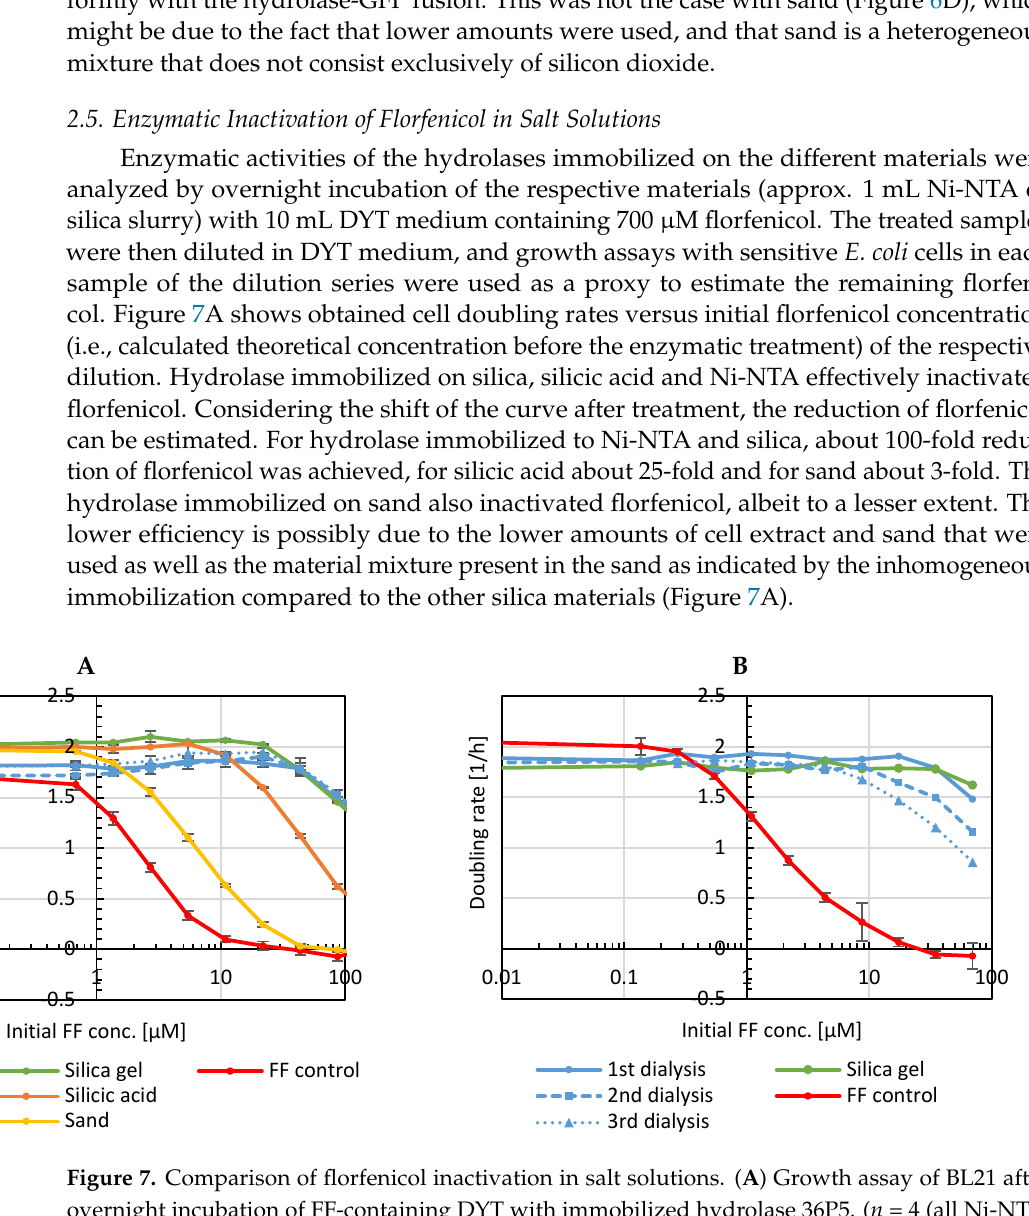
Figure 6. Microscope images of the immobilized hydrolase mutant 36P5. ( A ) Ni-NTA material; ( B ) silicic acid; ( C ) silica gel; ( D ) grinded sand. The figure shows the bright field (left), fluorescence (center) and superimposed images (right).